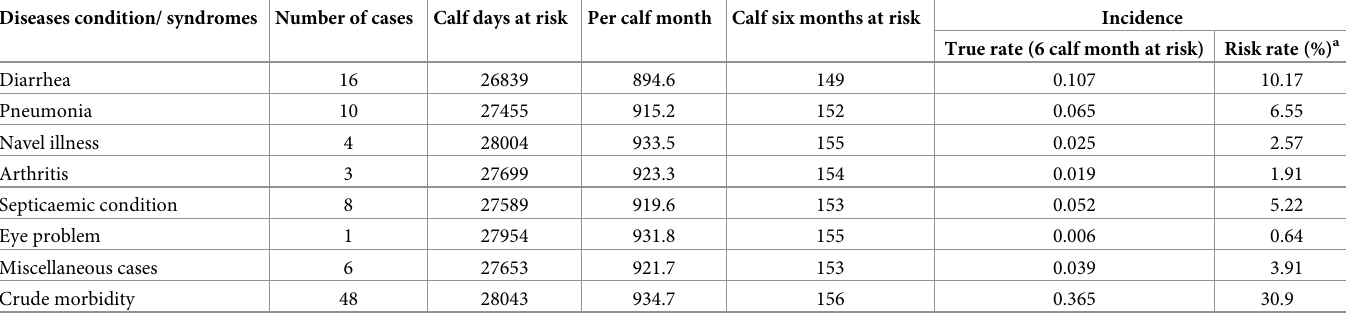
Table 4. The incidence of different diseases and disease conditions/syndromes in